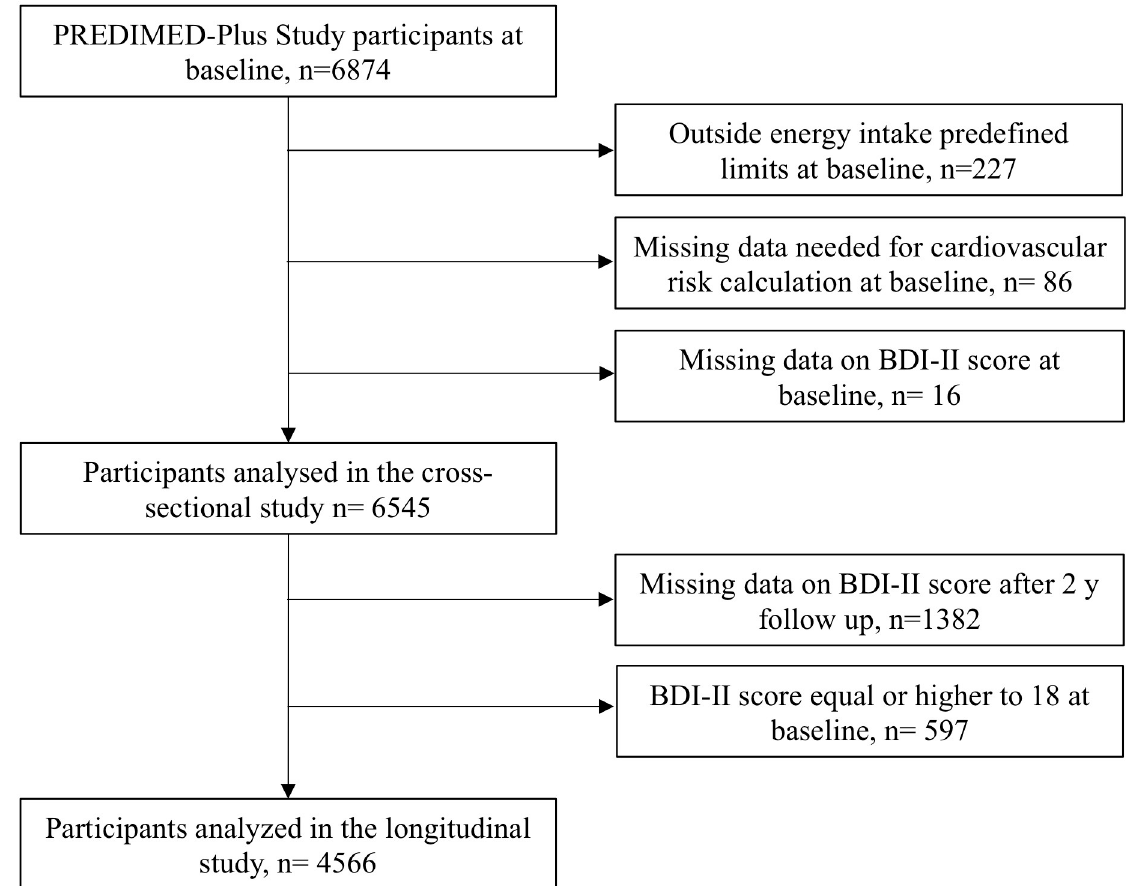
Fig 1. Flow chart for the analysis of cardiovascular risk and depression in the PREDIMED-PLUS trial. CVR, cardiovascular risk; BDI-II, Beck Depression